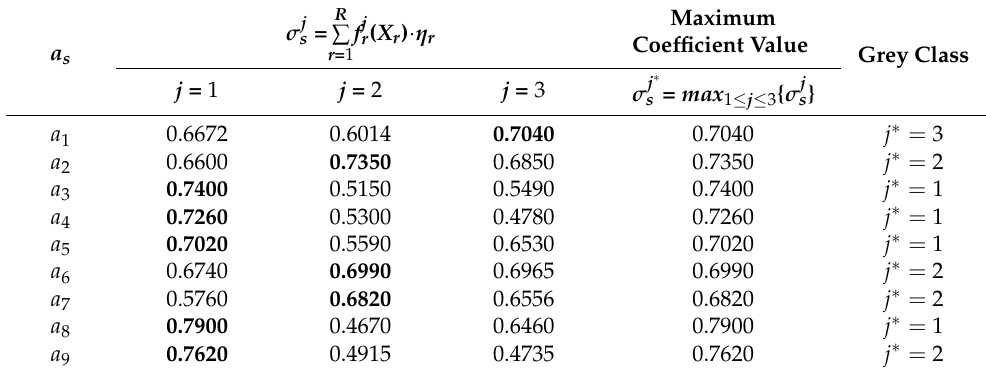
Table 18. Grey fixed weight cluster coefficients for each class